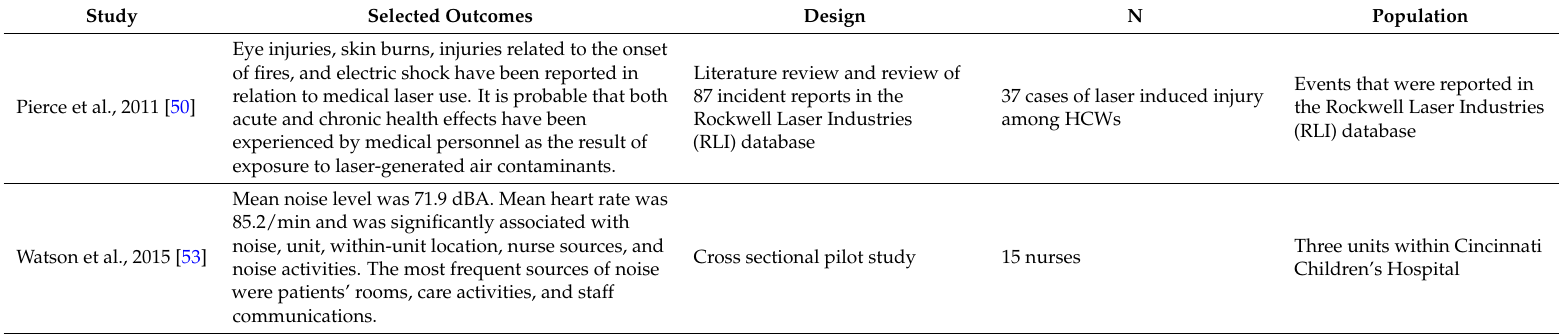
Table 4. Summary of literature reviewed for occupational health and safety hazards to nursing assistants—physical